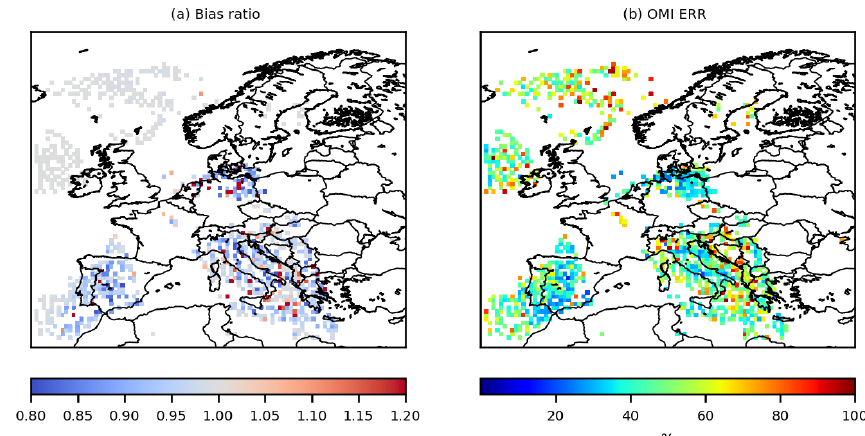
Figure 9. (a) Bias ratio between CHIMERE simulations using the posterior emissions against prior TNO-GHGco-v1 emissions compared to the OMI-QA4ECV-v1.1 observations. All ratios lower than 1, in blue, demonstrate that posterior emissions improve the simulation compared to the prior ones. (b) OMI uncertainties, in %, for 19 February